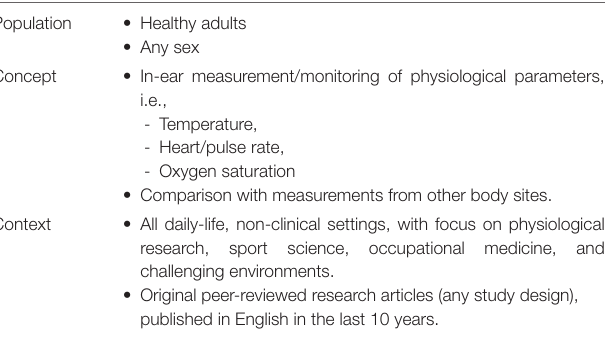
TABLE 1 | Inclusion criteria for the scoping review summarized according to the Population-Concept-Context (PCC) mnemonic, recommended for scoping reviews (Peters, 2016; Munn et al.,